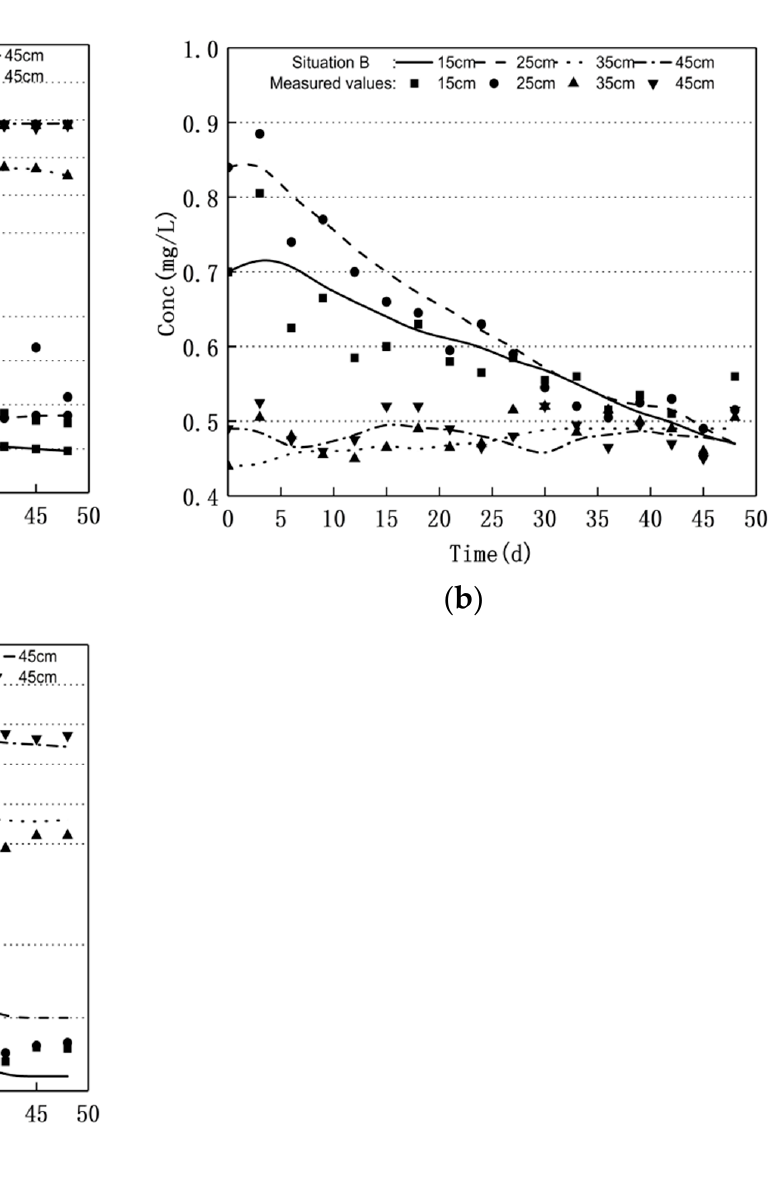
Figure 13. The measured results of medium sand and the dynamic process of nitrogen in situation